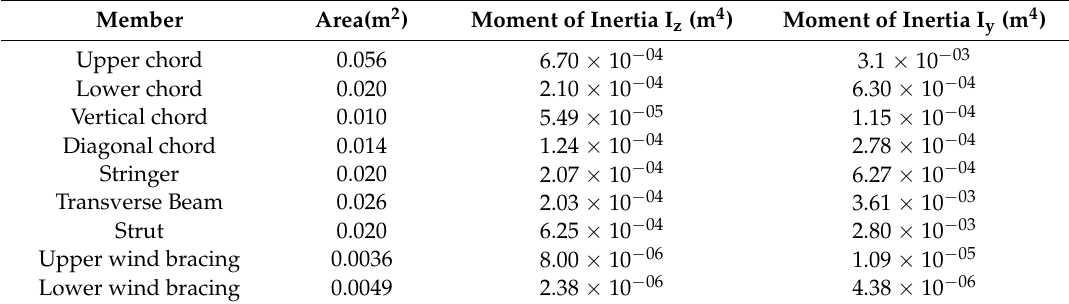
Table 2. Cross-sectional properties of truss members.